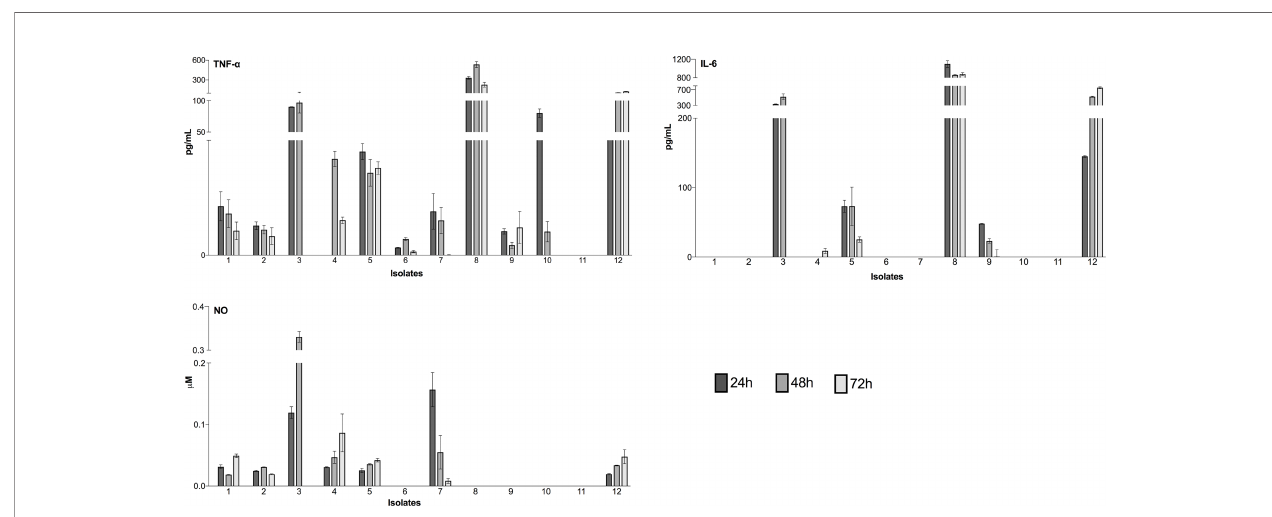
FIGURE 3 | Detection of in fl ammatory mediators during infection of peritoneal macrophages. Luminex assays detected cytokines (TNF- a and IL-6), and a colorimetric reaction was performed to assess the nitric oxide (NO) concentration. The culture time was assessed at 24h, 48h and 72h. The results represent the differences between the values of infected macrophage culture supernatants and uninfected controls. The data for cytokines (pg/mL) and nitric oxide (µM) concentration are expressed as the means and standard deviation. The values are representative of three independent